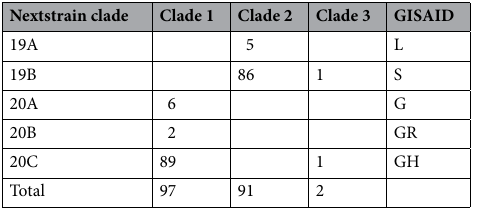
Correlation of sequence variants with clinical outcomes. Viral clade appeared to correlate with several baseline clinical characteristics as shown in Table 5. When stratified between clade 1 and clade 2 infec- tions, there was a significant difference in patients with a history of CVD, malignancy, steroid/IMT use, and anti-coagulation as well as in patients with a smoking history ( p values: 0.005–0.03). Comorbidity with CVD and cancer history was associated with clade 2 infection (OR: 3.1, 3.1, respectively) (Table 6). History of steroid/ IMT and anticoagulation use was associated with clade 2 infection (OR: 2.7, 5.0 respectively). Notably, patients with clade 2 infections were more likely to have never smoked tobacco (OR: 2.0), while patients with clade 1 infections were more likely to be active smokers (OR: 3.6). In multivariable analyses, a history of malignancy was